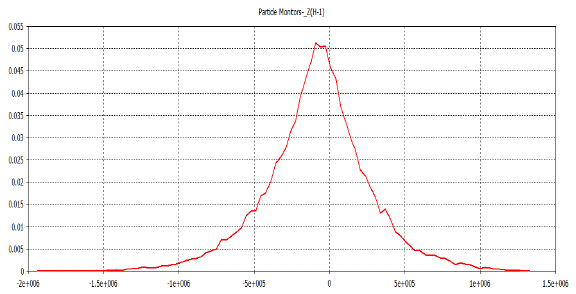
Fig. 5. Simulated distribution of parasitic electron transverse velocities caused by emitter surface roughness Simulations of electron-wave interaction based on the averaged equations and 3D PIC-code CST predict that BWO with the existing hollow beam can provide output power up to 300 W (Fig. 6) and wideband frequency tuning.